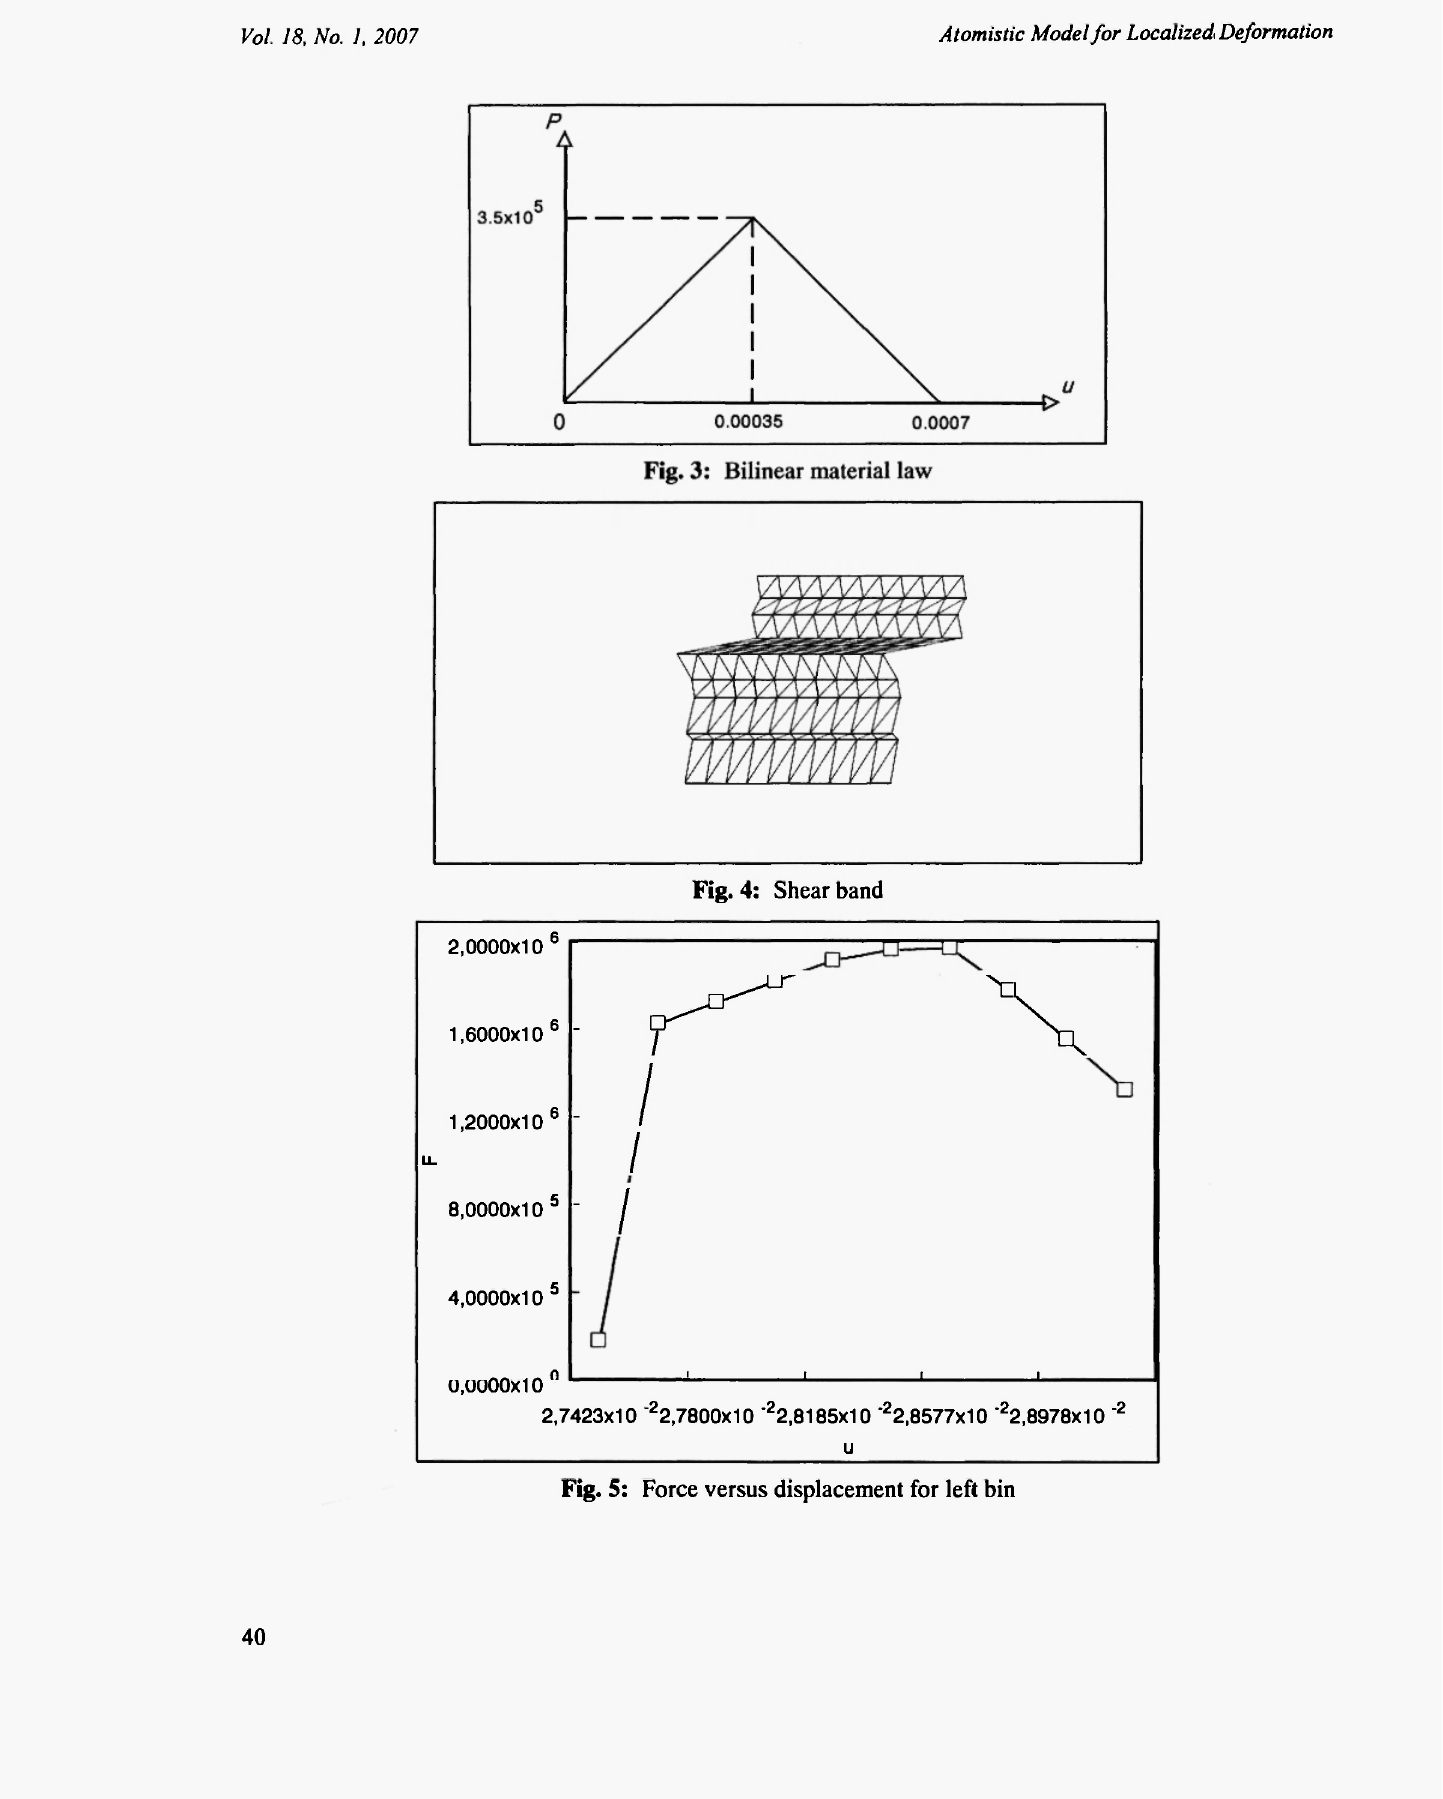
Fig. 4: Shear band